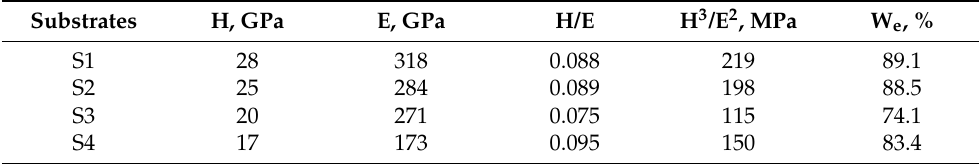
3.4. Wear Resistance of (Cr 1−x Al x )N/100Cr6 Sliding Pair Tribology tests of the (Cr 1−x Al x )N coating utilized steel (100Cr6) and ceramic (Al 2 O 3 ) Tribology tests of the (Cr 1 − x Al x )N coating utilized steel (100Cr6) and ceramic (Al 2 O 3 )